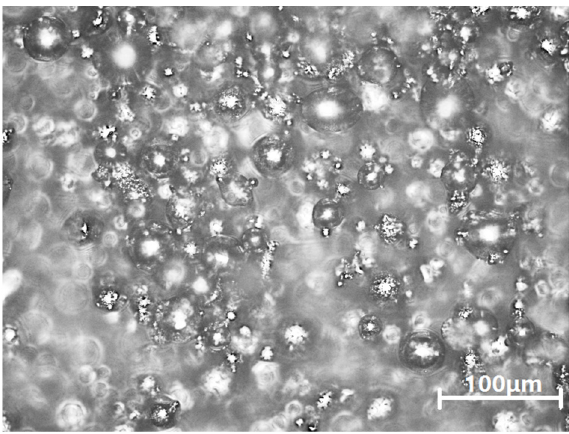
Figure 1. Inconel 625 Powder morphology.